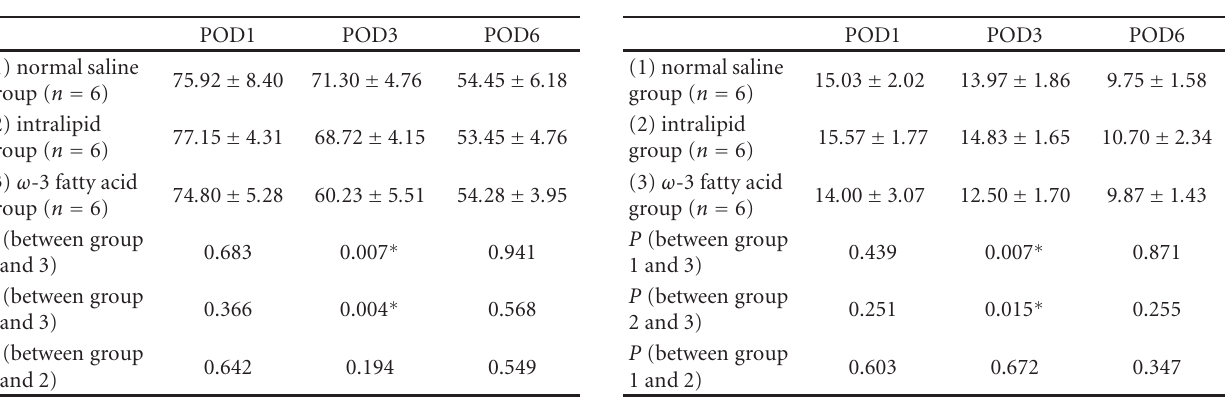
Table 5: IL-1 (pg/mL).